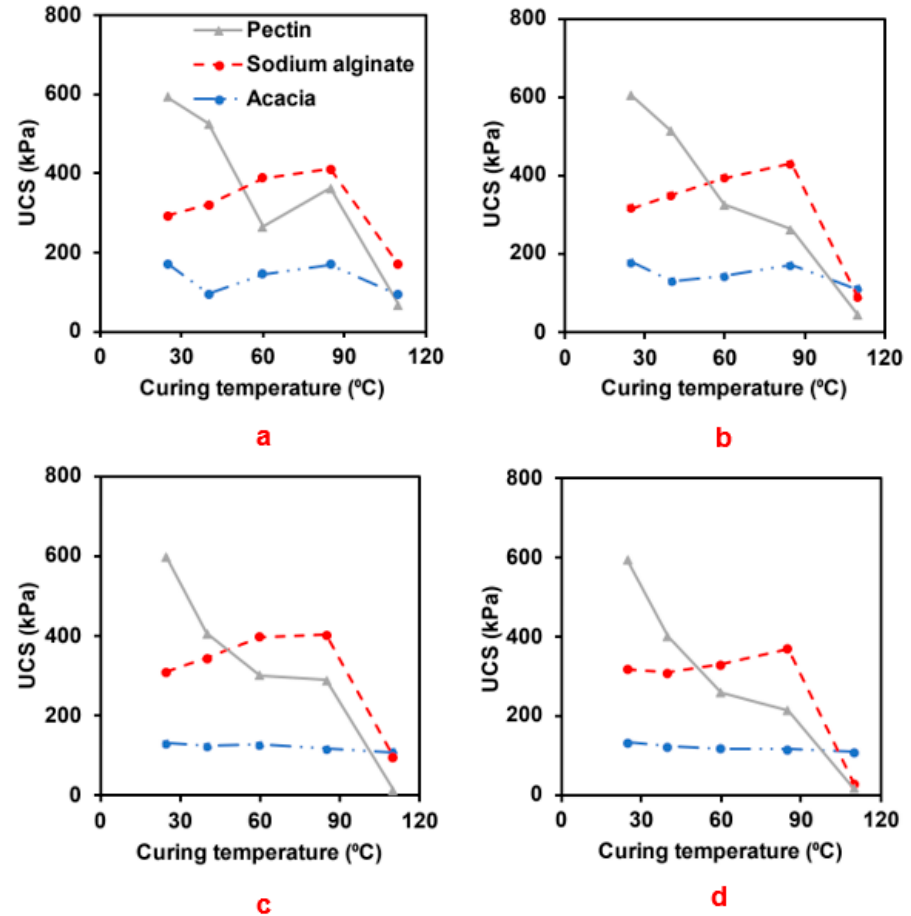
Figure 7. Effect of the curing temperature on the UCS of 2% biopolymer-modified sand at ( a ) 7 days, ( b ) 14 days, ( c ) 28 days, and ( d ) 56 days.